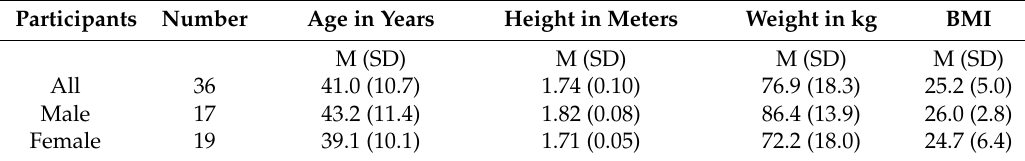
Table 1. Anthropometric information about the study sample; M = Mean; SD = Standard Deviation. Participants